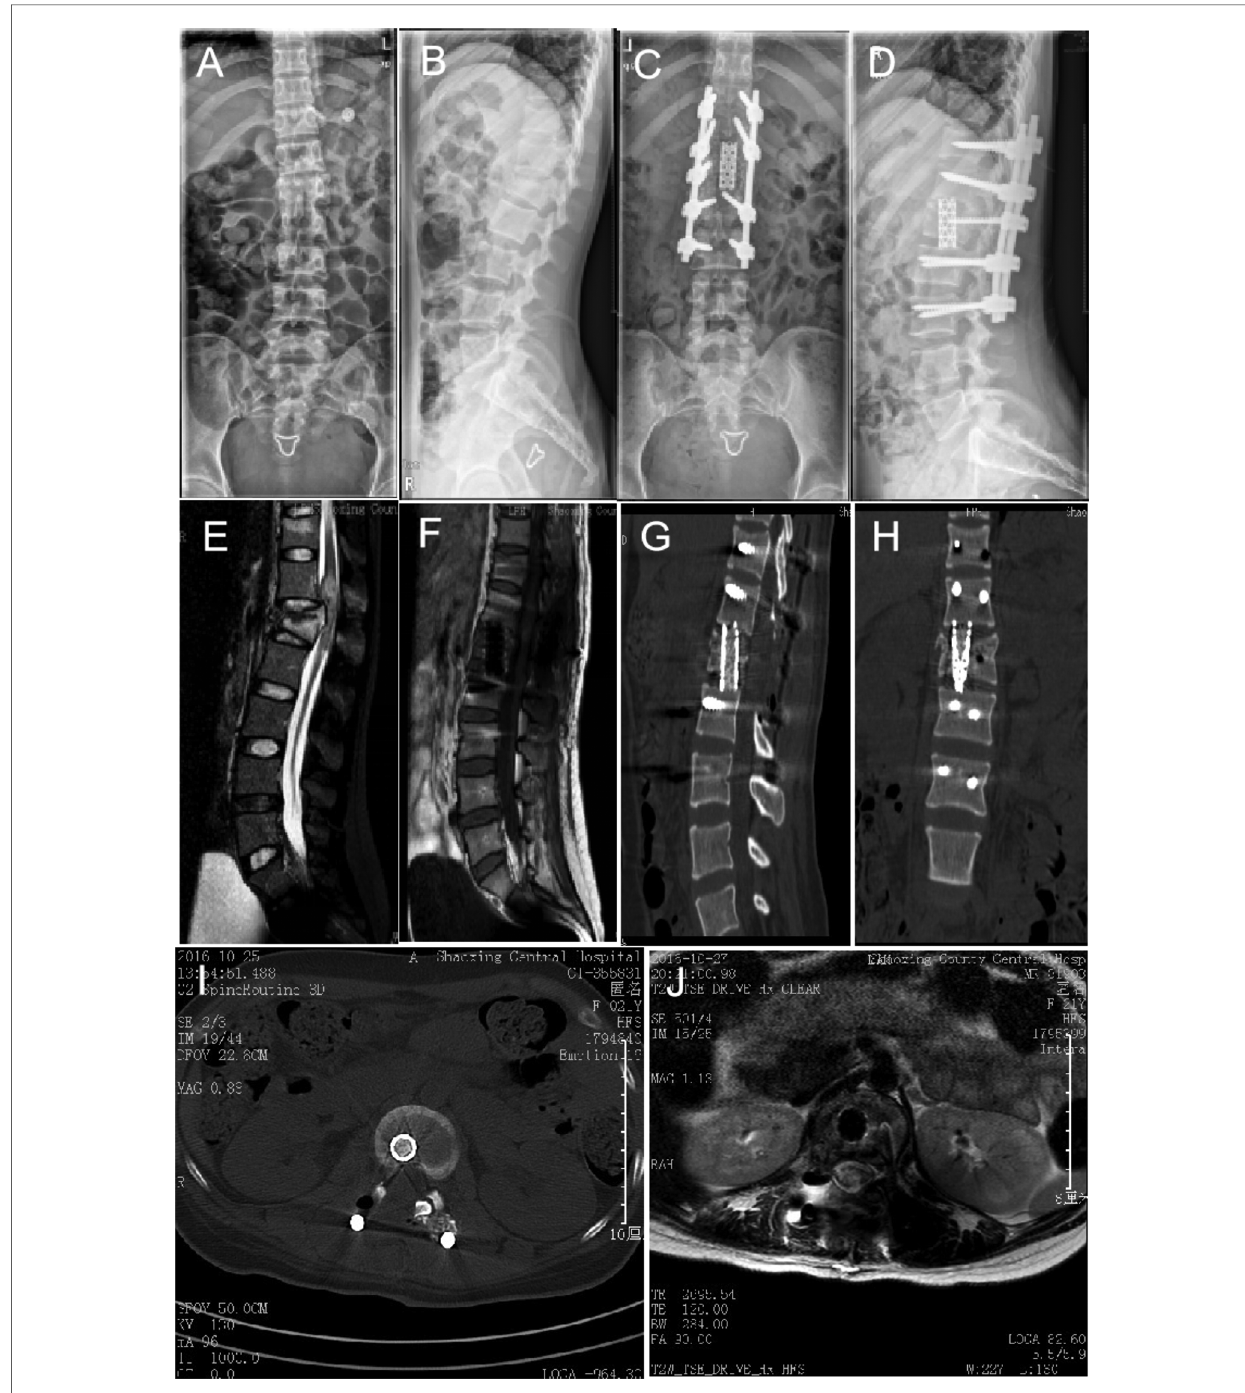
FIGURE 2 Typical preoperative, postoperative, and follow-up images of severe thoracolumbar burst fractures with posterior midline spinal approach for spinal canal limited decompression and 13-mm titanium mesh implantation (case #2). ( A,B ) True lateral digital x-rays of the patient ’ s thoracolumbar spine before the operation showing the L1 fracture. ( C,D ) True lateral digital x-rays of the thoracolumbar vertebrae after the operation showing good fi xation and recovery of the height of the anterior edge of the L1 vertebra. ( E,F ) Preoperative magnetic resonance imaging (MRI) showing L1 burst fracture, spinal cord compression, and obvious spinal canal occupancy. ( G – J ) Postoperative MRI indicates no spinal cord compression and no spinal canal occupancy. ( I ) Postoperative computed tomography (CT) indicates a good position of the titanium mesh, screws, and titanium